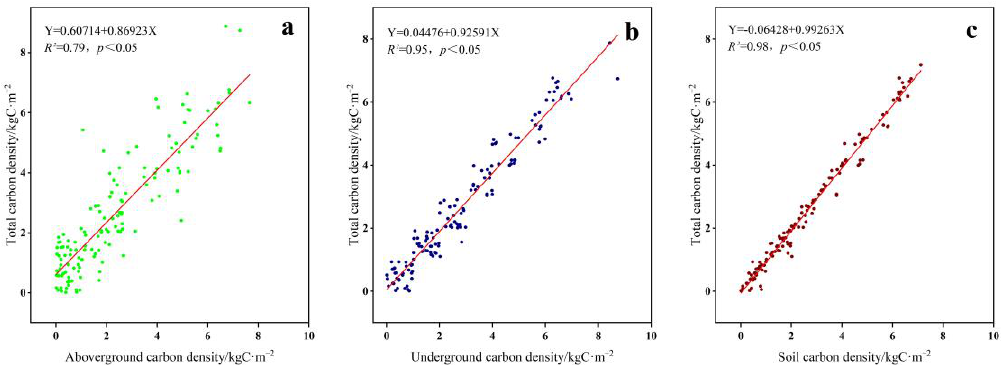
Figure 3. Distribution of various types of carbon pools in Zoigê alpine grassland.